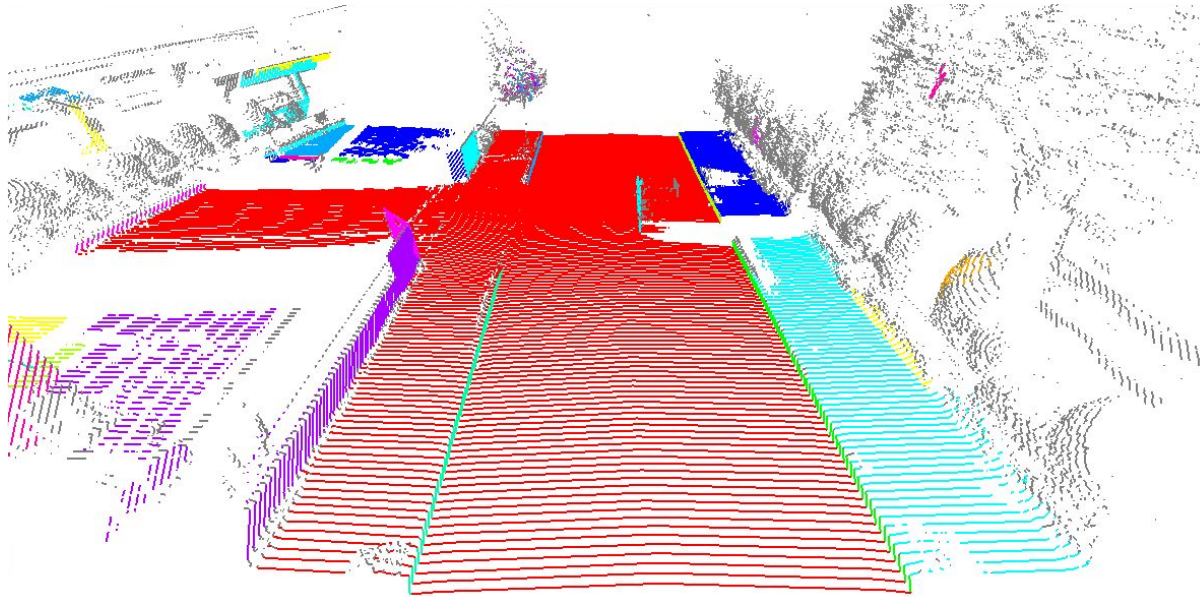
Figure 11: The result of detecting planar structures by line-based region growing.